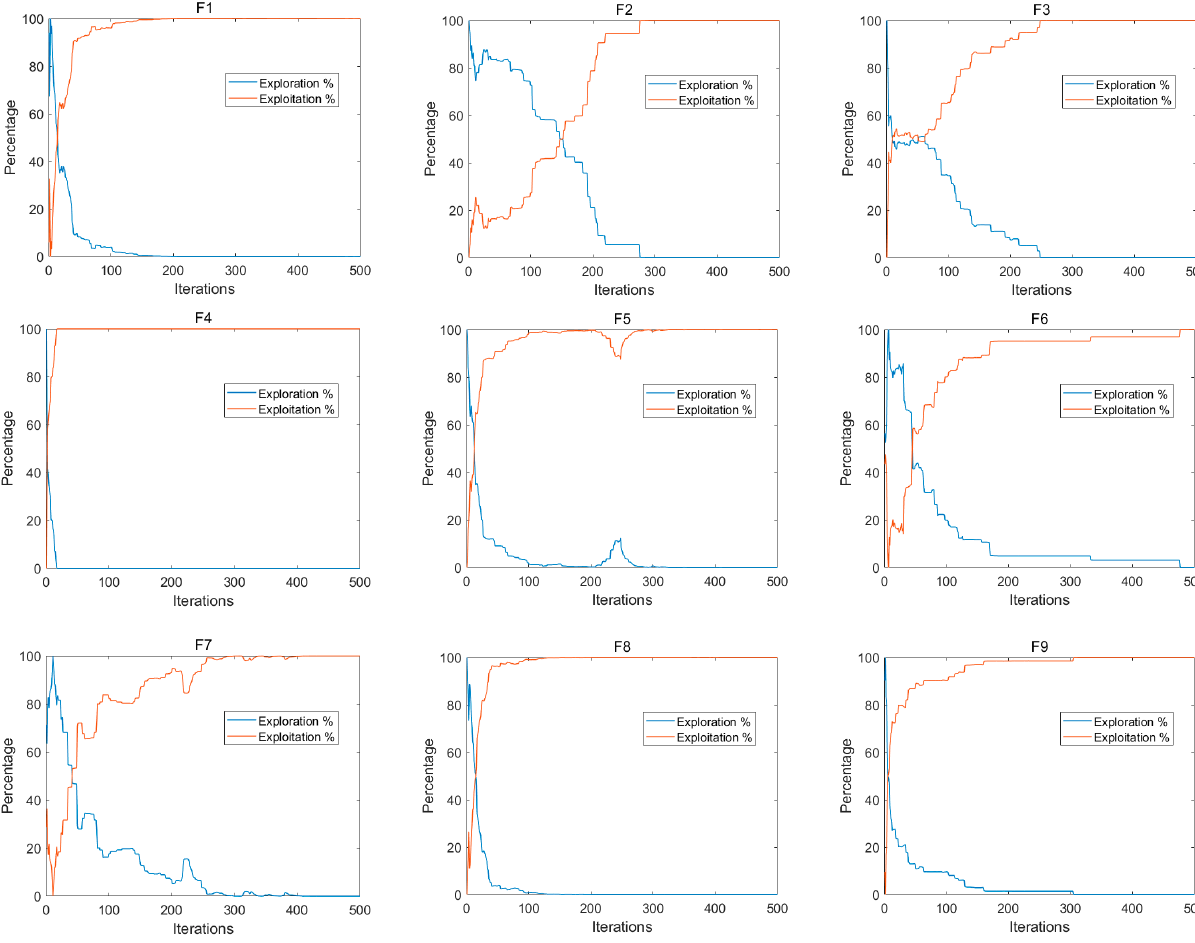
Figure 7. Exploration and exploitation phases for the MGTO algorithm using CEC2020. 5. Constrained Engineering Design Problems In this section, seven engineering problems were selected to test the optimization performance of the MGTO algorithm. The selected engineering problems are those of pressure vessel design, reducer design, welding beam design, tension/compression spring design, cantilever beam design, multi plate clutch brake failure, and vehicle collision op- timization. Each algorithm was run independently 30 times. The specific experimental re- sults are as follows. 5.1. Pressure Vessel Design Problem The pressure vessel design problem aims to minimize the total cost of cylindrical pressure vessels to meet pressure requirements. There are four variables to be optimized for this problem, namely: vessel wall thickness T S , head wall thickness T h , inner diameter R , and vessel body length L . See Figure 8 for a detailed schematic diagram. The specific mathematical model is as follows: